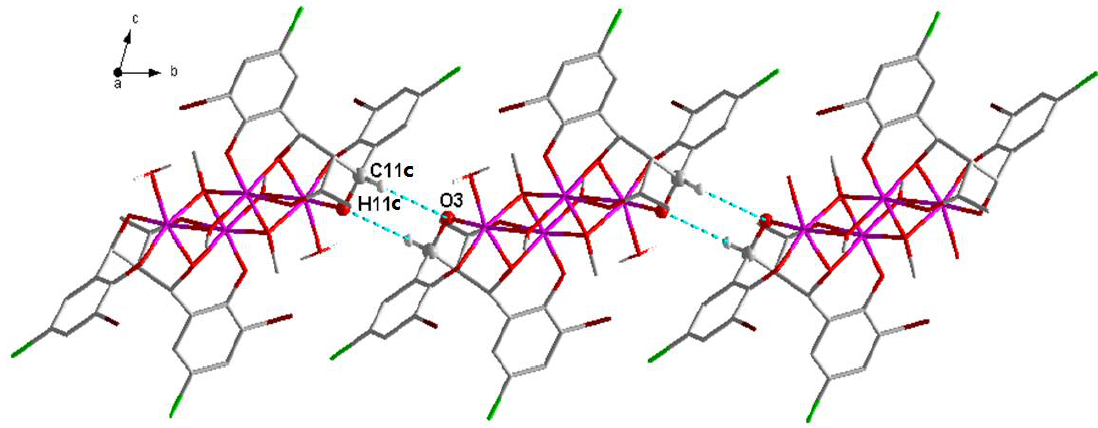
Figure 10. 1D supramolecular structure containing C11c–H11c···O3 hydrogen bond interactions in